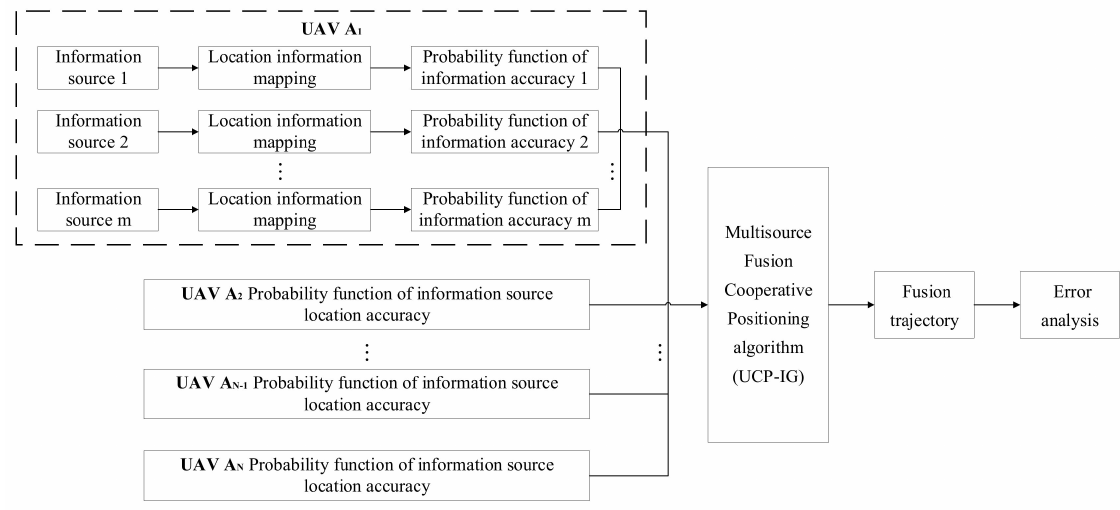
Figure 3. Flow chart of UAV cluster multisource fusion based on information